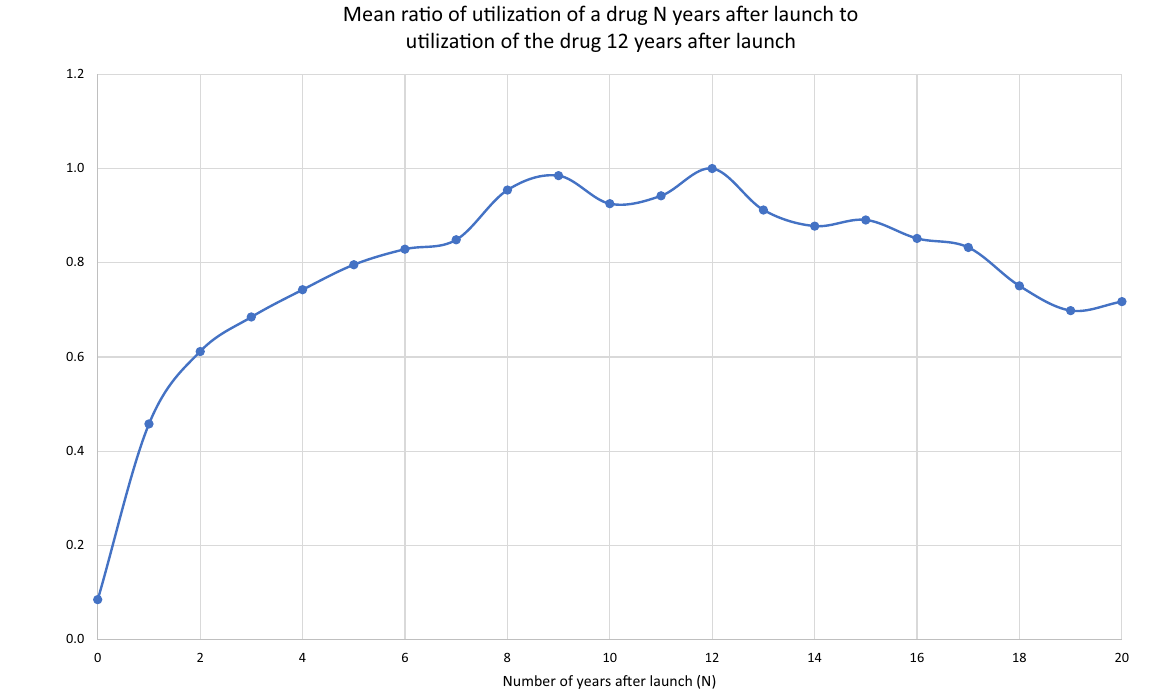
Fig. 2 Mean ratio of utilization of a drug N years after launch to utilization of the drug 12 years after